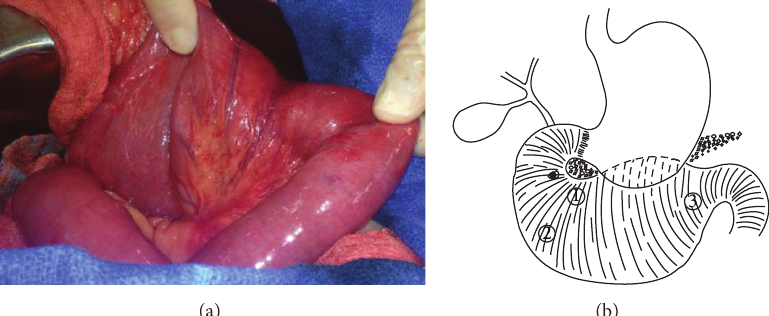
Figure 3: (a) Intraoperative photograph showing the duodenal duplication. (b) Schematic representation of intraoperative findings; included numbers correlate with endoscopic findings shown in Figure 2.